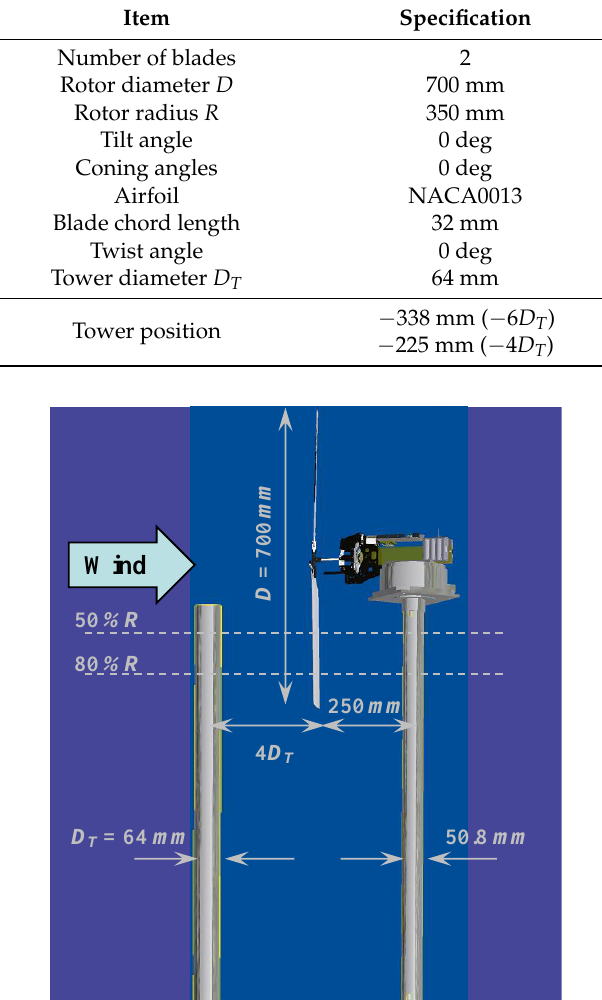
Figure 3. Schematic of the test model (dummy tower at −4 D T ).